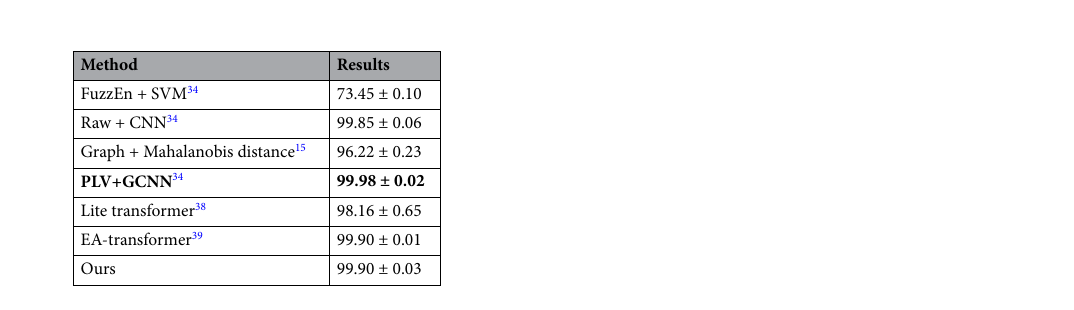
Table 3. Results of models training on diverse states and testing on diverse states. Results are accuracy in testing stage (average ± standard deviation)%. Significant values are in